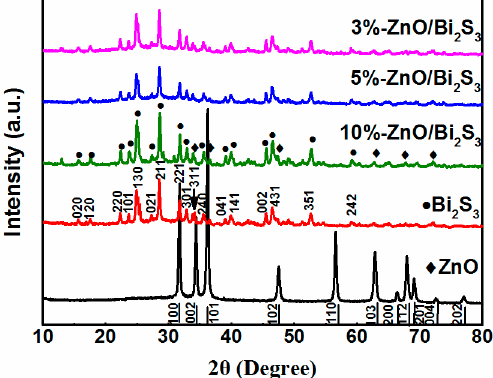
Figure 1. XRD patterns of ZnO, Bi 2 S 3 , and ZnO/Bi 2 S 3 composites with different ZnO contents.